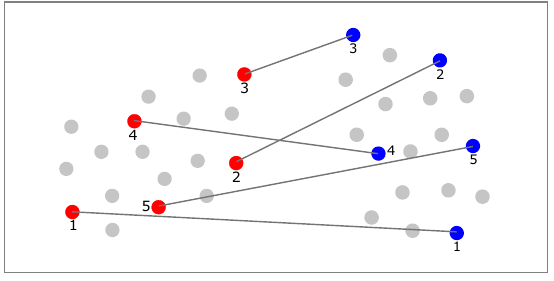
Figure 11. Fine alignment tuning and